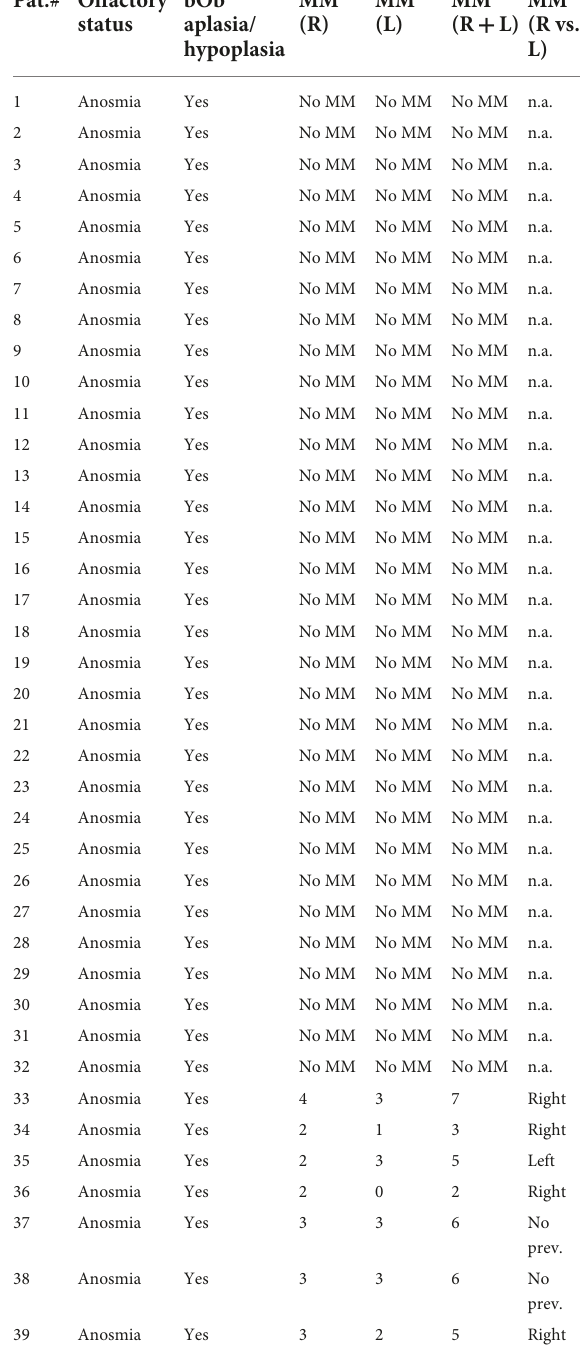
TABLE 1 Patients’ clinical